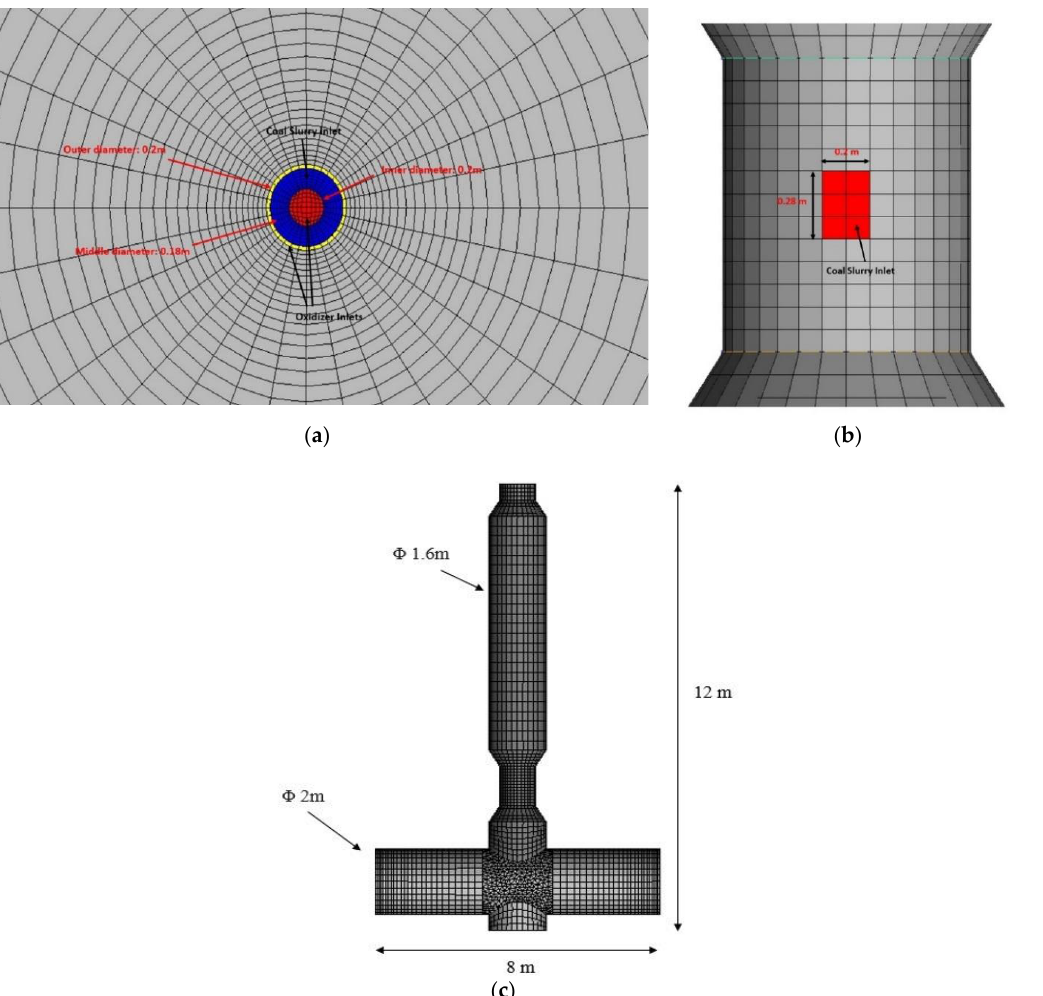
Figure 3. ( a ) First stage inlet, ( b ) second stage inlet, and ( c ) computational grid of the geometry used in this study. Table 3 . Proximate analysis of coal used in study. Table 2. Ultimate analysis of coal used in study.